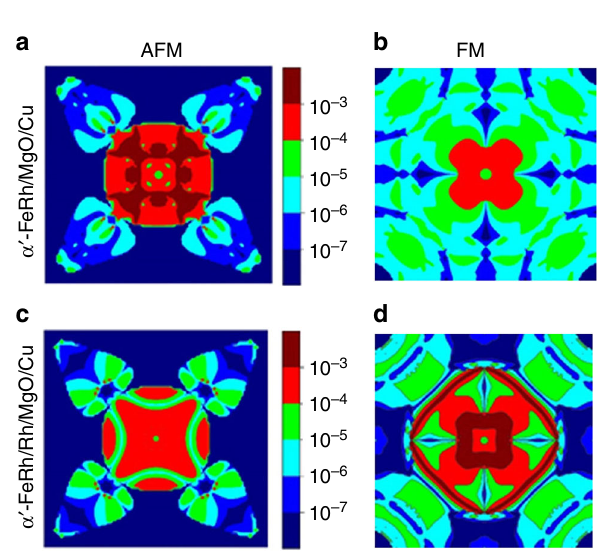
Fig. 4 Transmission distribution in two-dimensional Brillouin zone for α ′ -FeRh/MgO(2.5 u.c.)/Cu and α ′ -FeRh/Rh(1 u.c.)/MgO(2.5 u.c.)/Cu junctions at Fermi level. a , b Minority-spin channels at AFM and FM states for α ′ -FeRh/MgO/Cu junctions. c , d Minority-spin channels at AFM and FM states for α ′ -FeRh/Rh/MgO/Cu